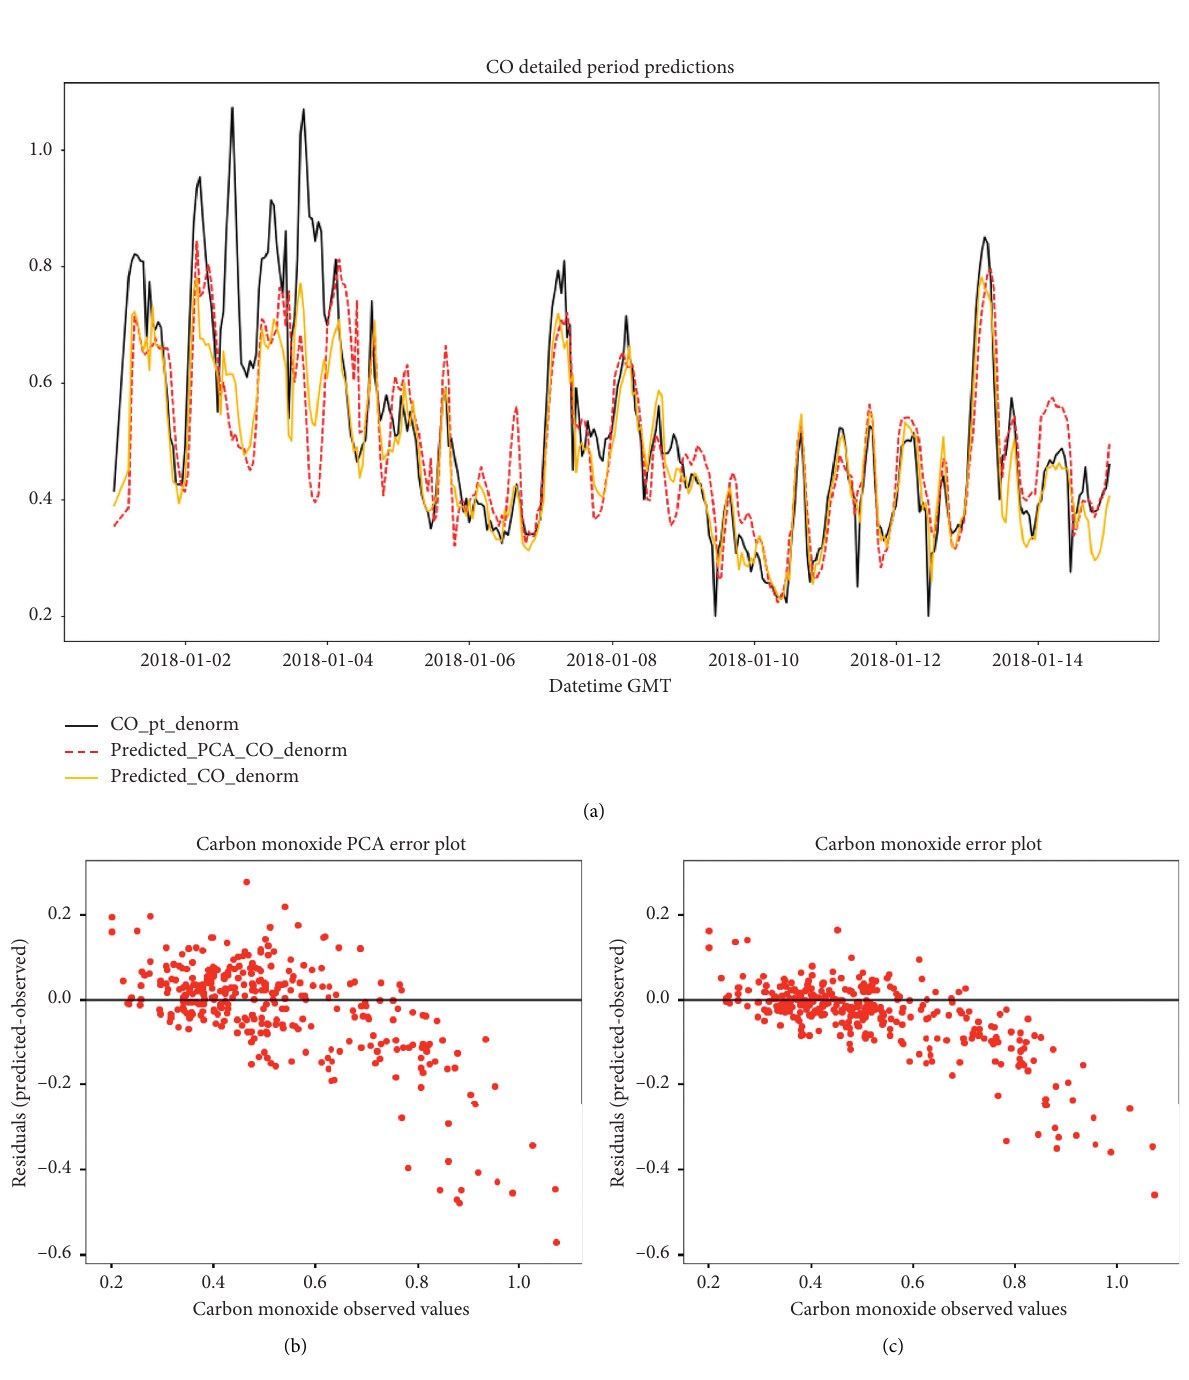
Figure 9: (a) Carbon monoxide forecast detail between the period of the 1st of January and the 15th. Both forecasting methods missed to forecast some of the spikes registered in the series in the beginning of January. (b, c) Two scatter plots with model’s respective errors plotted against observed CO values for the same